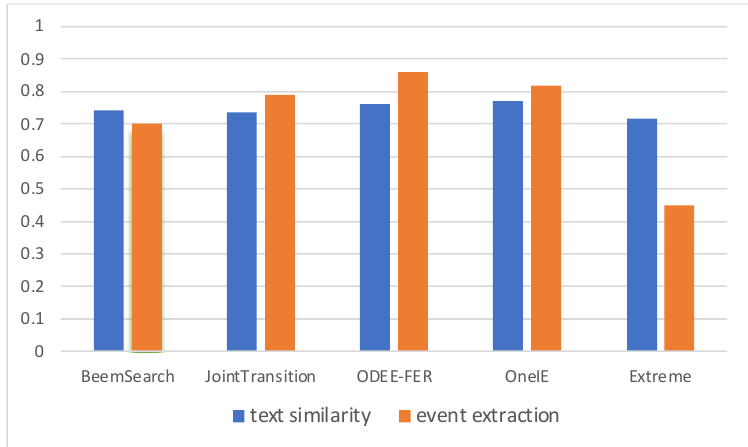
Figure 6. The histogram to see the results obtained by different event extraction methods (blue color indicates text similarity calculation task and orange color indicates event extraction task).